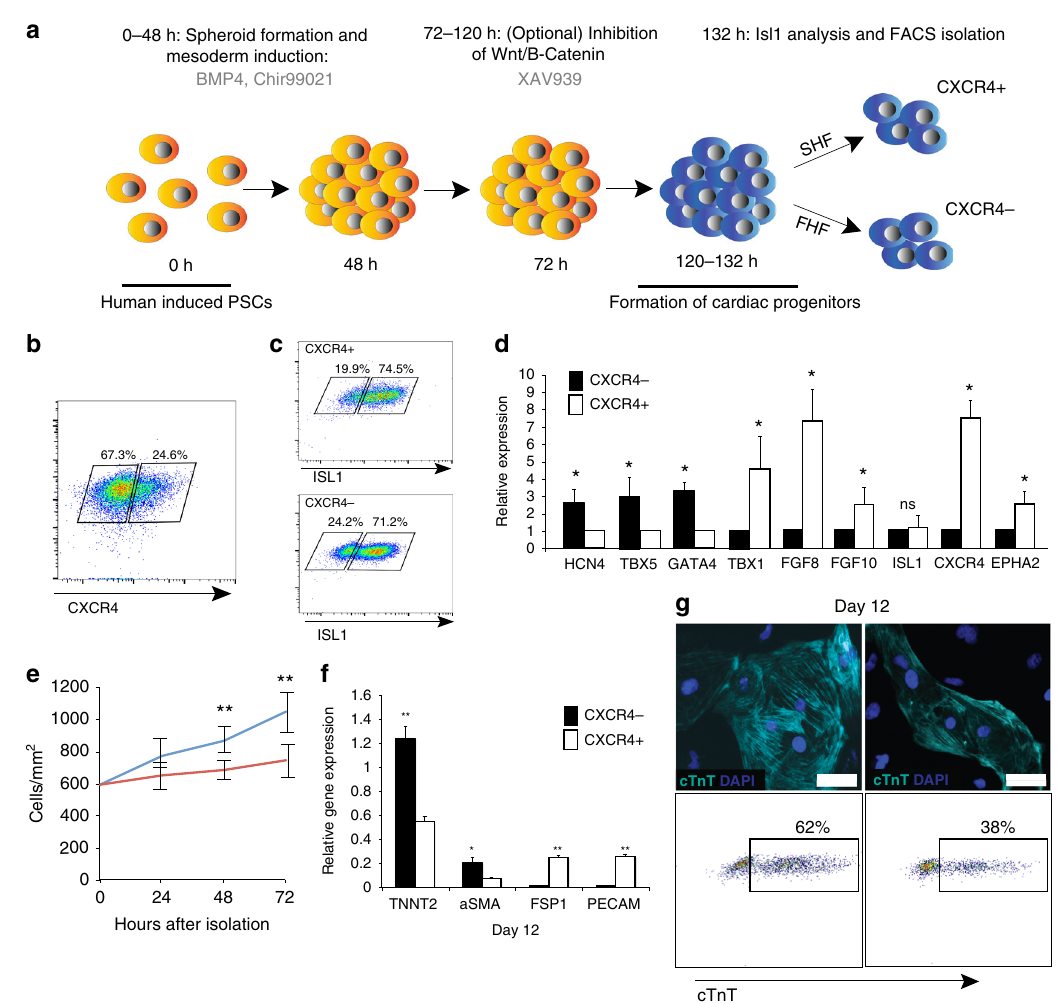
Fig. 5 CXCR4 identi fi es SHF progenitors in human iPSC-derived spheroids. a Schematic of the strategy used to generate and differentiate hiPSC-derived cardiac spheroids. b Representative fl ow cytometric analyses showing the number of CXCR4 − and Cxcr4 + cells at day 5.5. c Representative fl ow cytometric analysis showing the number of human Isl1 + cells in the sorted populations of CXCR4 + and CXCR4 − CPCs. d qPCR analyses of CXCR4 − and CXCR4 + cells isolated at day 5.5. Data are mean ± SEM; * p < 0.05; ** p < 0.01; ns not signi fi cant ( p > 0.05). p values were determined using a paired Student ’ s t test. e Cell counts of CXCR4 − and CXCR4 + cells isolated day 5.5. Data are mean ± SEM; ** p < 0.01. p values were determined using a paired Student ’ s t test. f qPCR analysis of Tnnt2, aSMA (smooth muscle cell marker), Fsp1 ( fi broblast marker), and PECAM (endothelial cell marker)